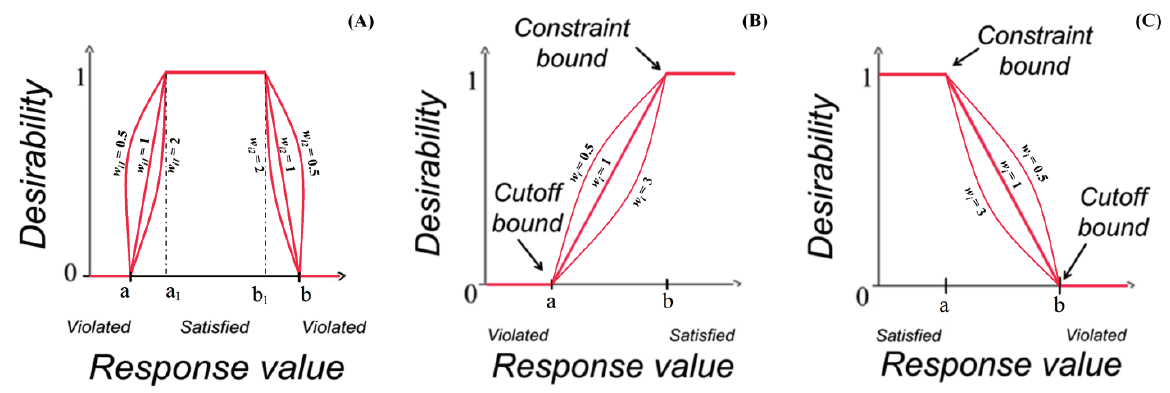
Figure 9. Schematic diagram of different desirability functions: ( A ) bilateral desirability function, ( B ) maximization and ( C )